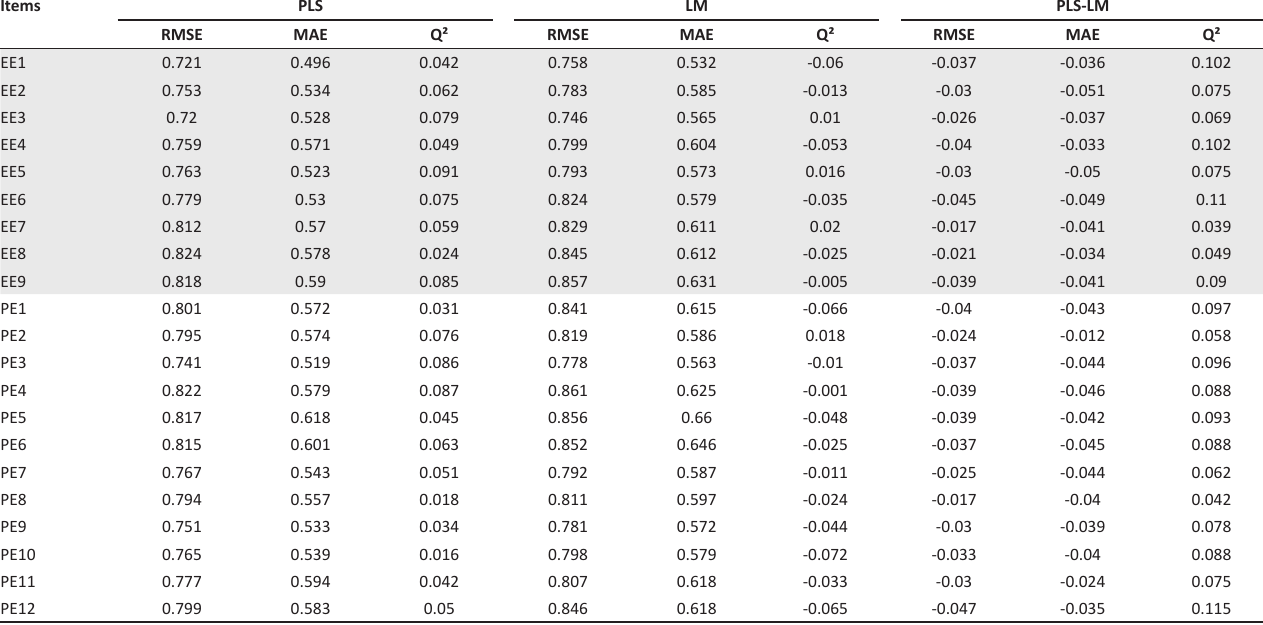
TABLE 3: Partial least squares-predict.